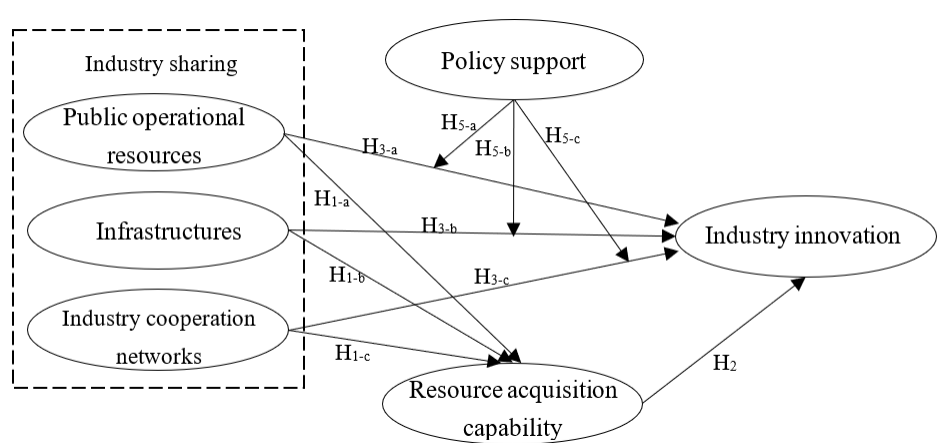
Figure 1. Conceptual model.